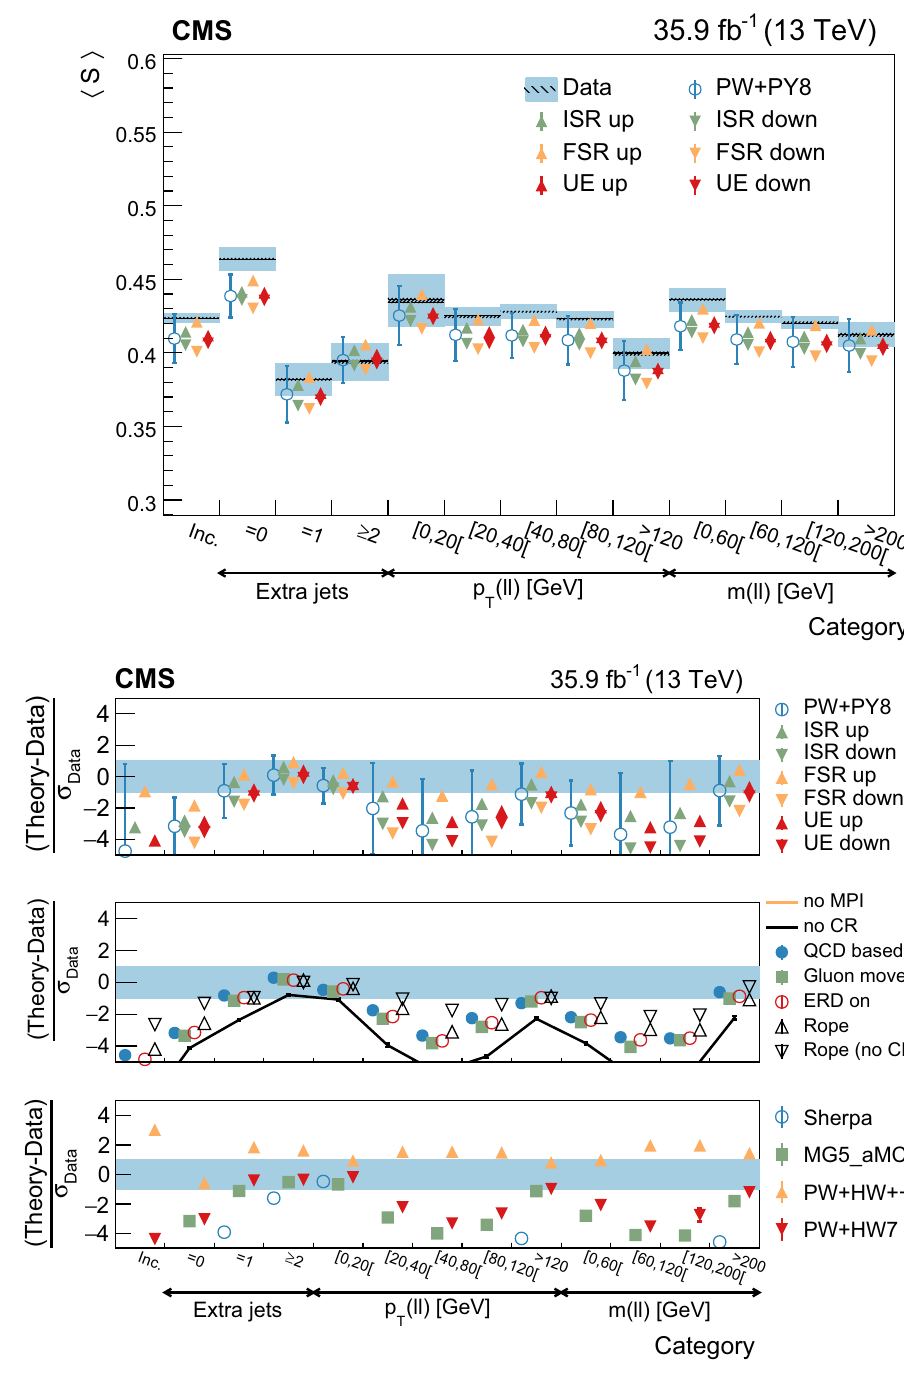
Fig. 20 Average sphericity in different categories. The conventions of Fig. 14 are